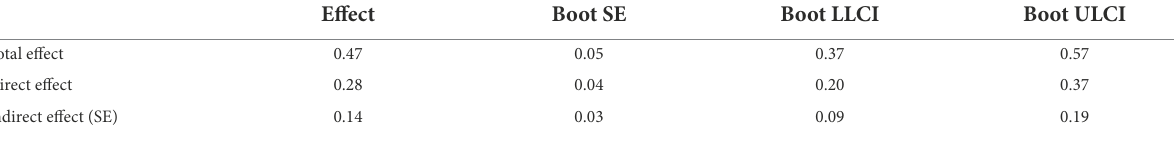
TABLE 8 Confidence interval.